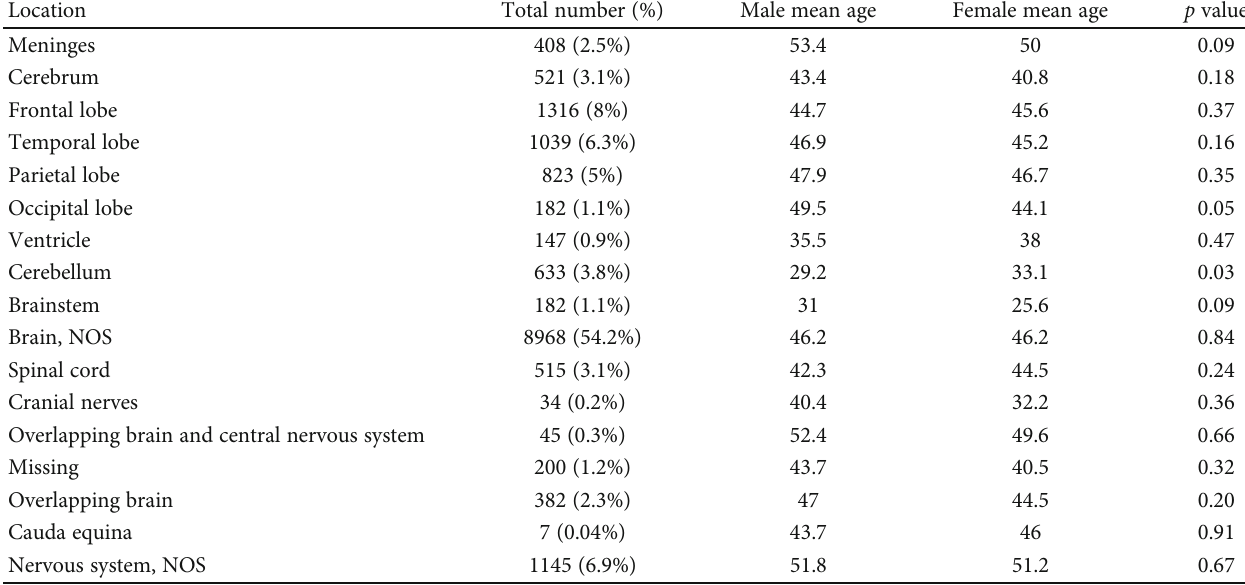
Table 3: Distribution of tumours in di ff erent sites (topography) and patients ’ mean